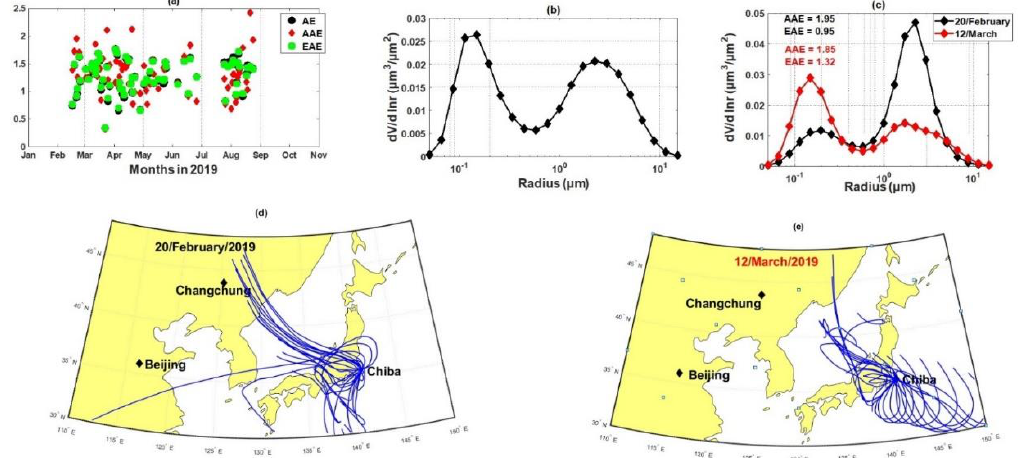
Figure 5. (top panel) ( a ) The Angstrom exponent (AE), absorption Angstrom exponent (AAE), and extinction Angstrom exponent (EAE) values in Chiba for the observation period. The AAE and EAE values were calculated using Equations (1) and (2). ( b ) The mean aerosol volume size distribution for the observation period. The volume size distribution data from the coincident AERONET observations were used. Only the coincident days between the SKYNET and AERONET observations were used in the calculation. ( c ) The aerosol volume size distribution for 20 February and 12 March. The days were selected based on AAE values. (bottom panel) ( d ) 48 h backward trajectories, starting from 200 m above ground level over the Chiba site on February 20, 2019. ( e ) Similar 48 h backward trajectory on 12 March 2019.